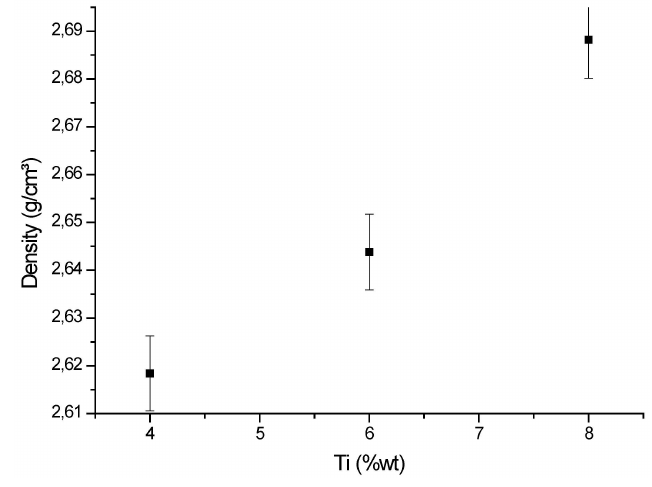
Figure 5. Densities of A356 alloy containing different amounts of